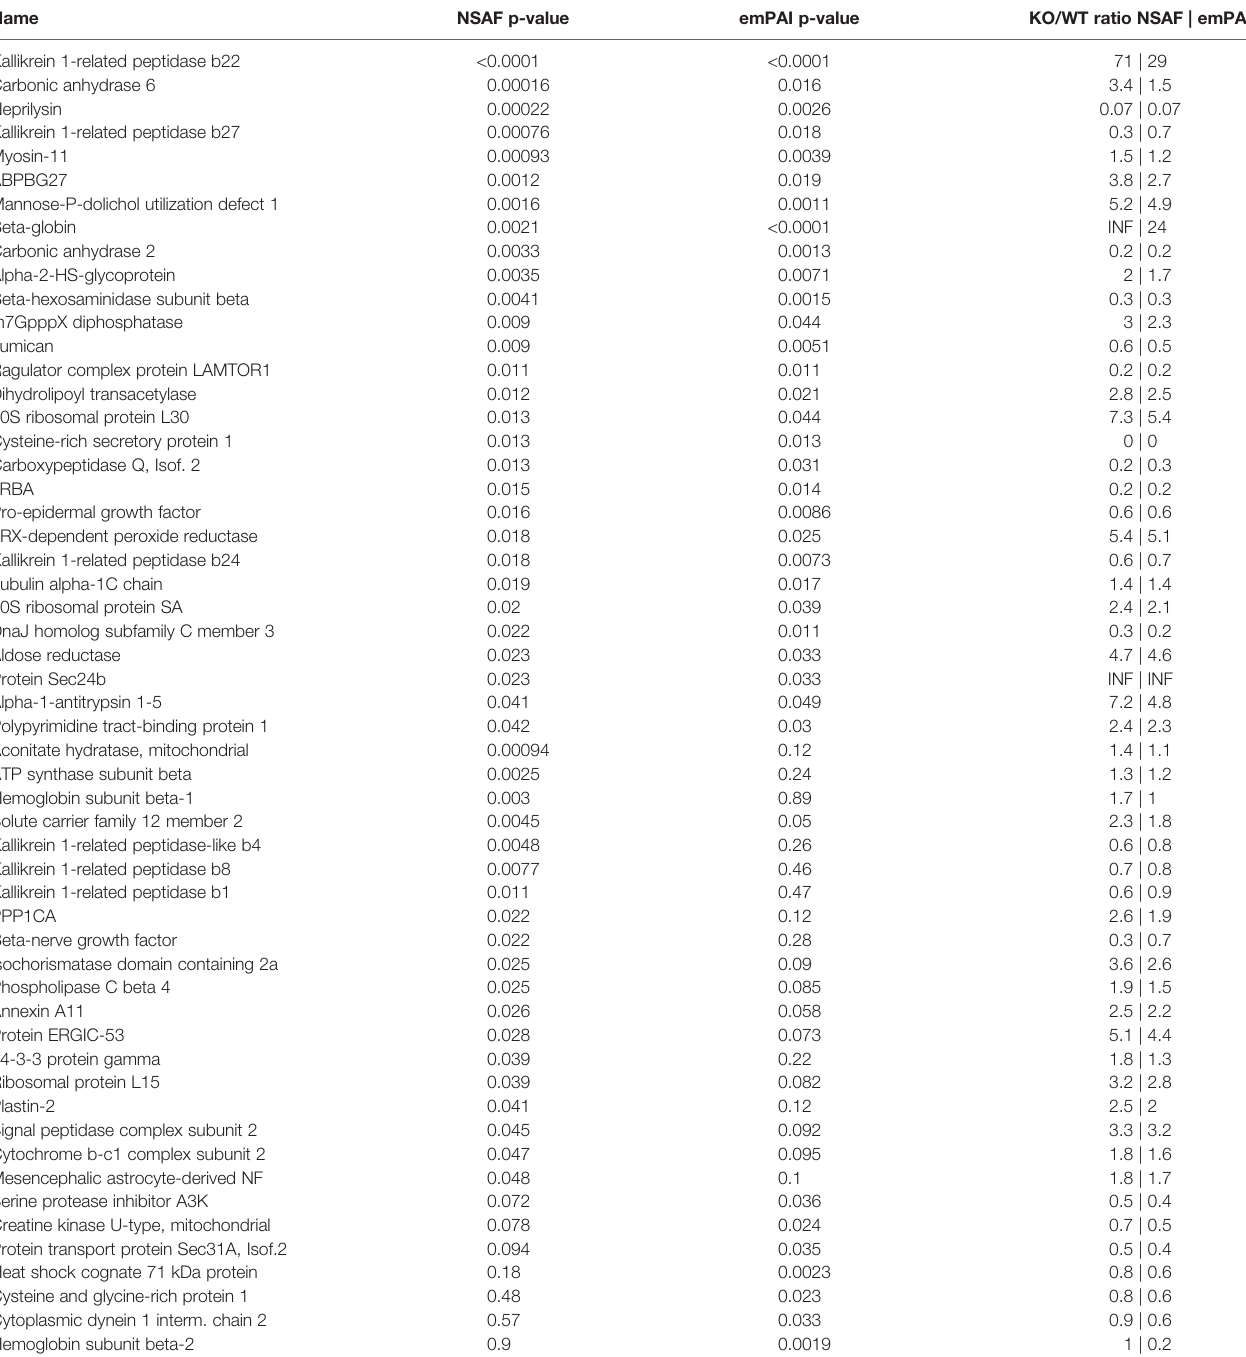
TABLE 3 | Identi fi ed proteins with signi fi cant differences in computed relative abundances between male wildtype and male knockout animals (MWT vs MKO).